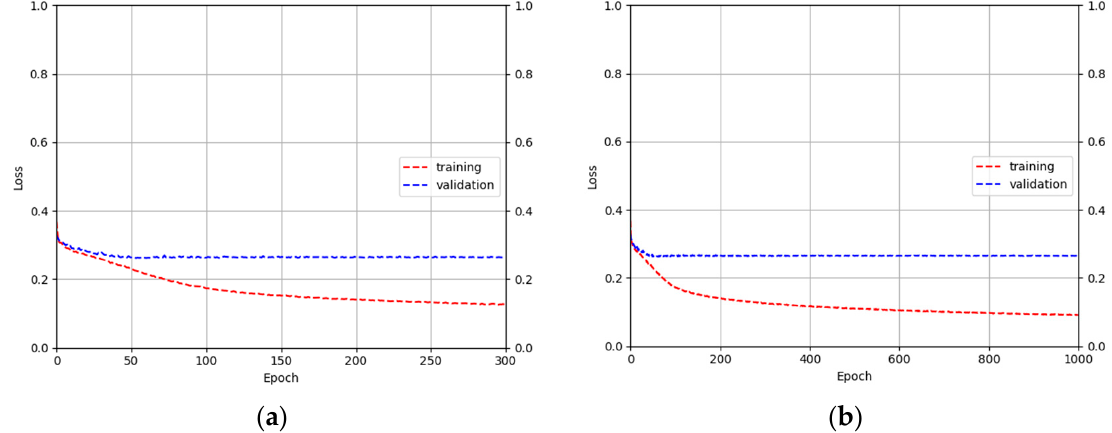
Figure 10. Training and validation loss graphs of RMOBF-Net. ( a ) trained until 300 epochs (attached in paper), ( b ) trained until 1000 epochs.